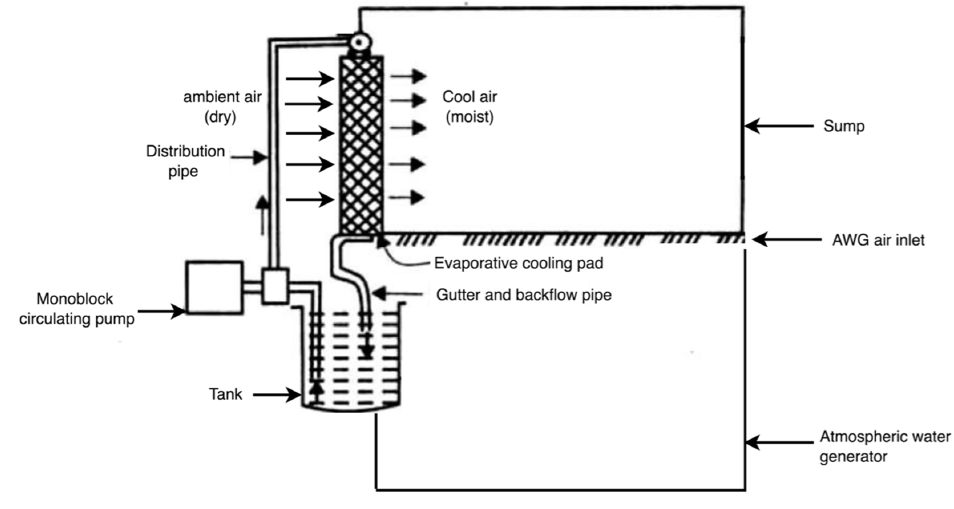
Figure 4. Schematic diagram of evaporative cooling system.